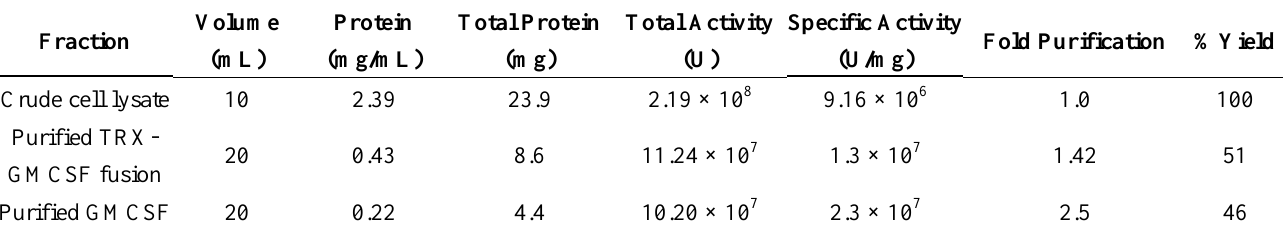
Table 1. Summary of purification of hGMCSF expressed as TRX fusion from 100 mL flask culture.